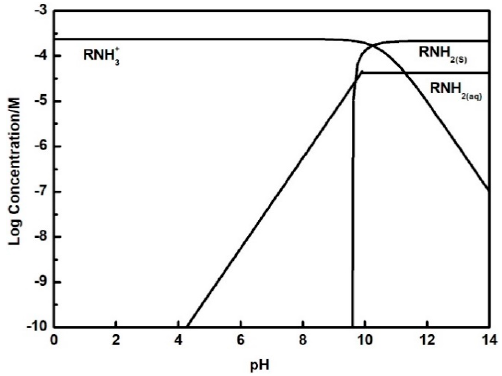
Figure 5. Logarithmic concentration diagram of DDA solution components. Figure 6. The bands at 2919 cm − 1 and 2852 cm − 1 are characteristic of the stretching vibrations of -CH 2 -